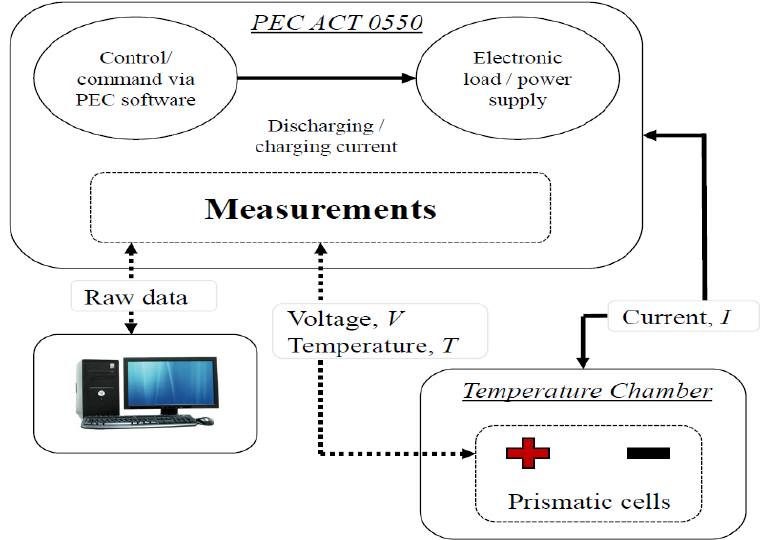
Figure 1. Block representation of test bench topology during cell experiment [19].